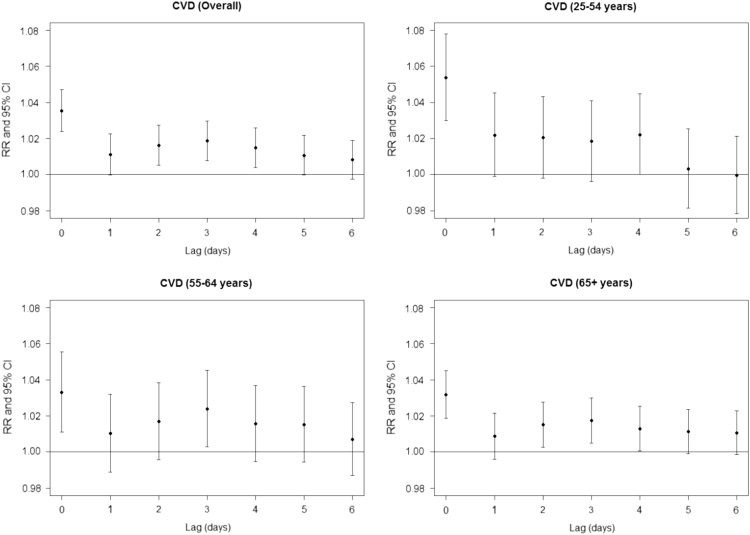
Relative risks (RR with 95% confidence intervals) for the association between NO2 and CVD per 10 µg/m3 increase of NO2 concentration obtained with the single lag model. Analysis performed for different age groups.